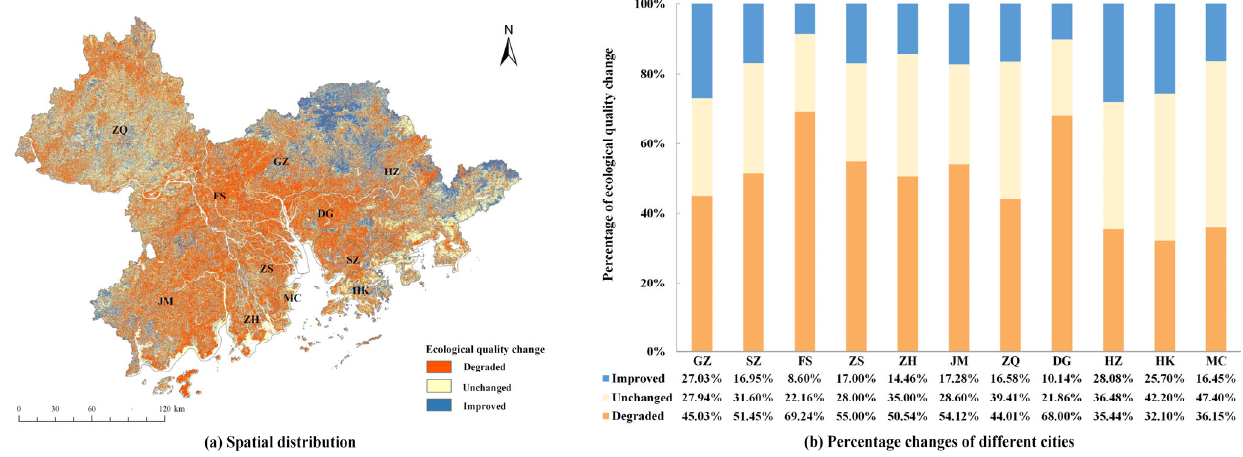
Figure 8. Ecological quality change of the GBA from 2000 to 2020.